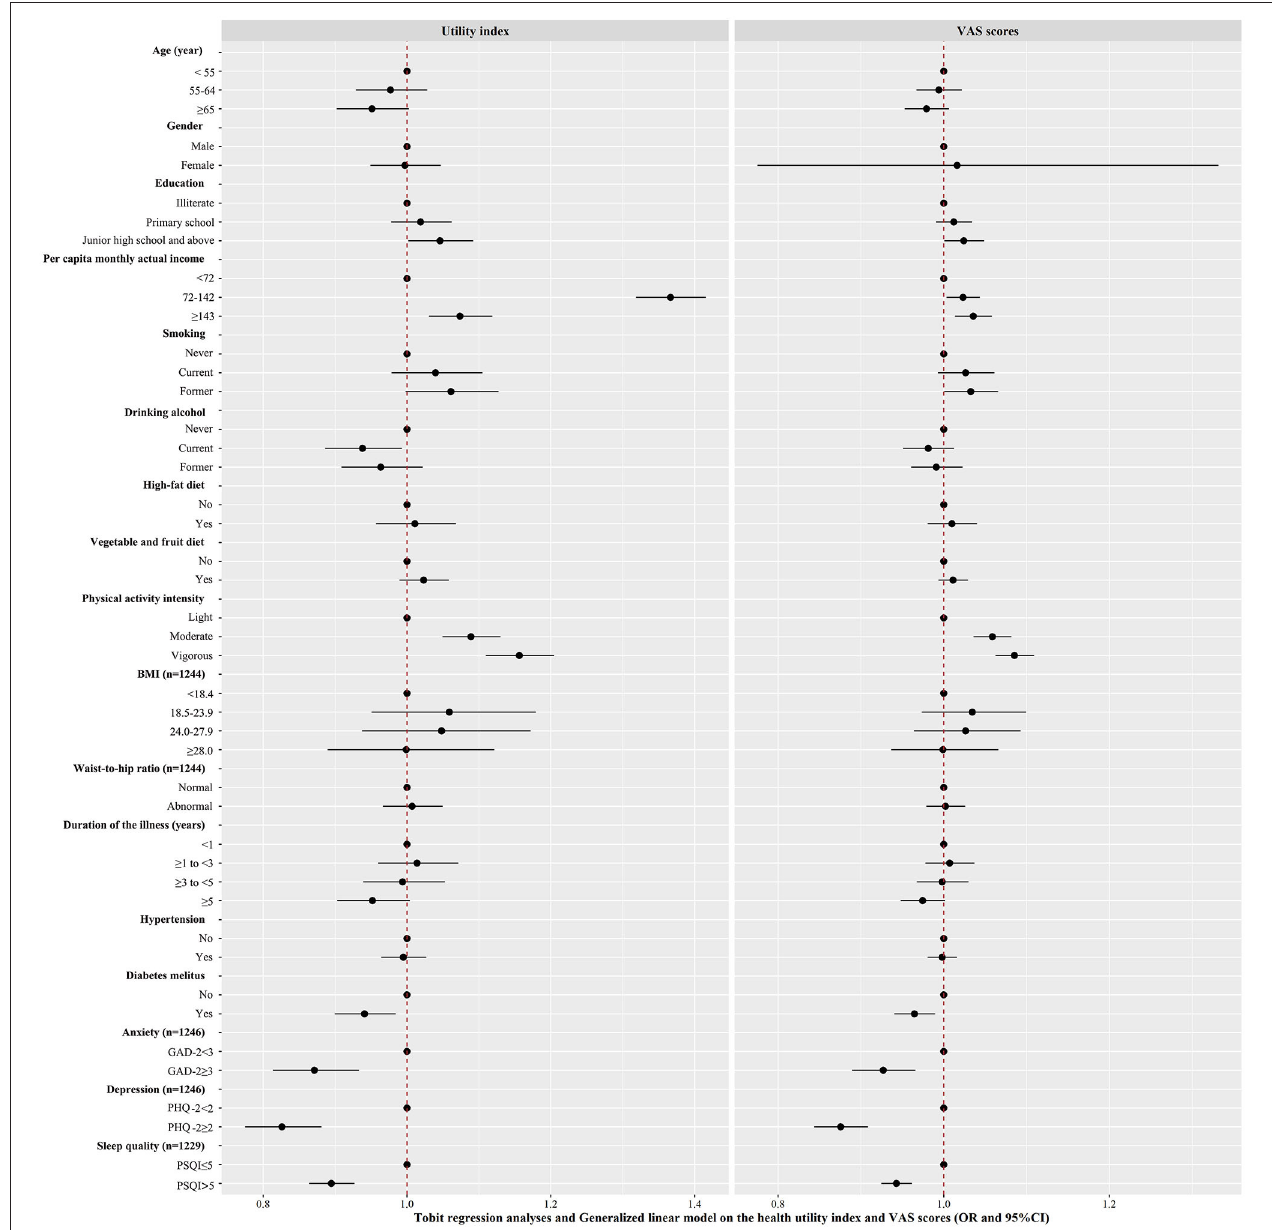
FIGURE 3 | Factors associated with EQ-5D-5L utility index and Visual Analogue Scale scores in patients with stroke were analyzed by Tobit regression and Generalized linear model, respectively ( n = 1,709). The estimated effect and 95% confidence intervals were represented by black squares with the corresponding error bars. A two-sided P -value 0.05 was considered statistically